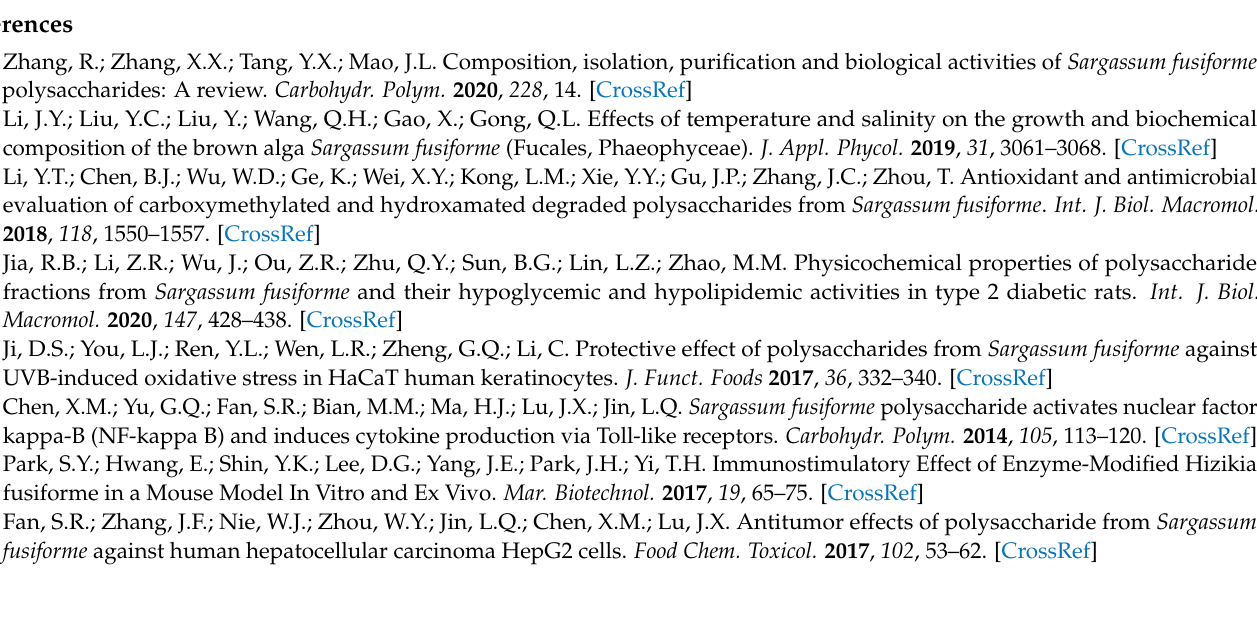
Figure S2: Morphology of GUVs after 10 min, 40 min, 90 min, 6 h and 24 h exposure to the SFP